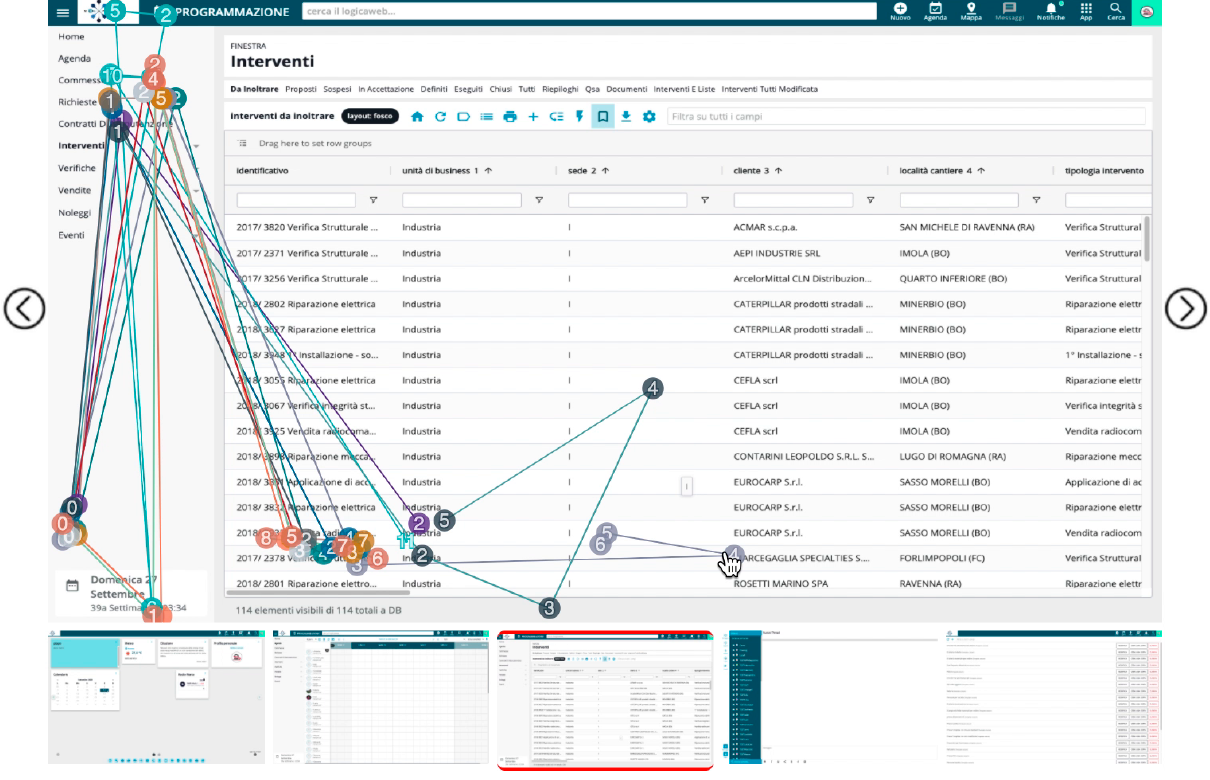
Figure 14. Click paths of users while performing task 2. Each participant is represented with a different colour. The numbers indicate the order in which the clicks were performed.